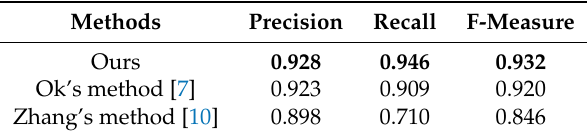
Figure 9. Comparison of final test results. Green is the positive detection area, blue is the false detection area, and red is the missed detection area. Table 2. IoU test results for three oil tank detection